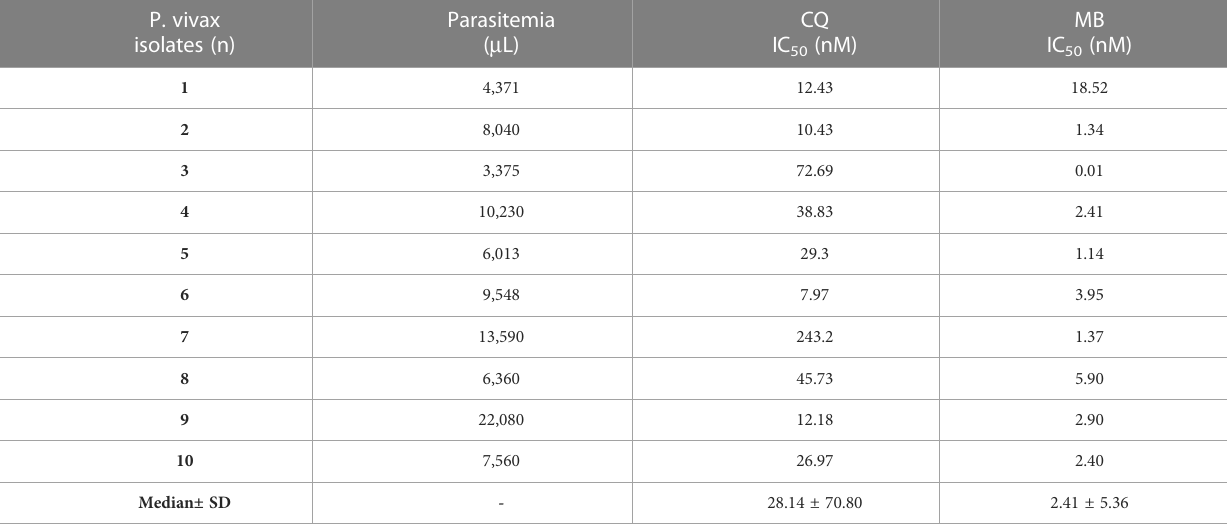
TABLE 1 Ex vivo activity against asexual P. vivax per